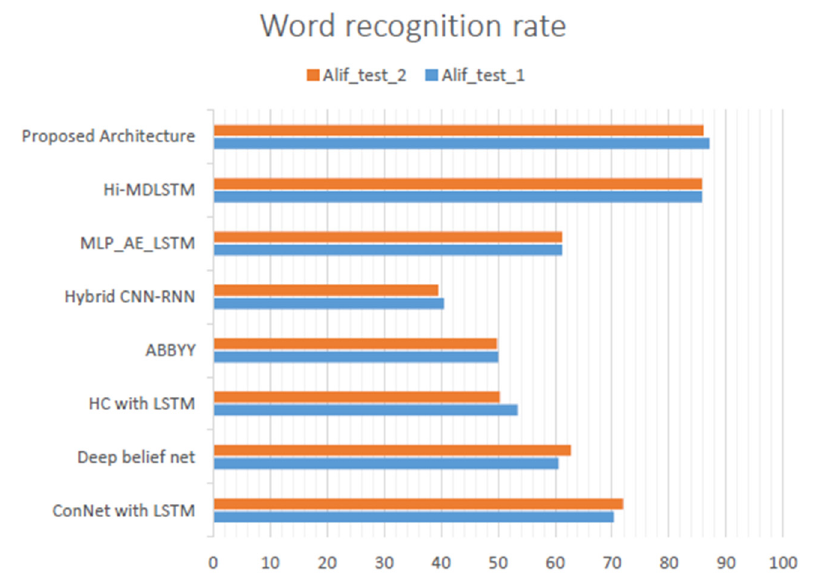
Figure 16. Comparison of proposed architecture with different architectures on word recognition rate (Alif dataset).